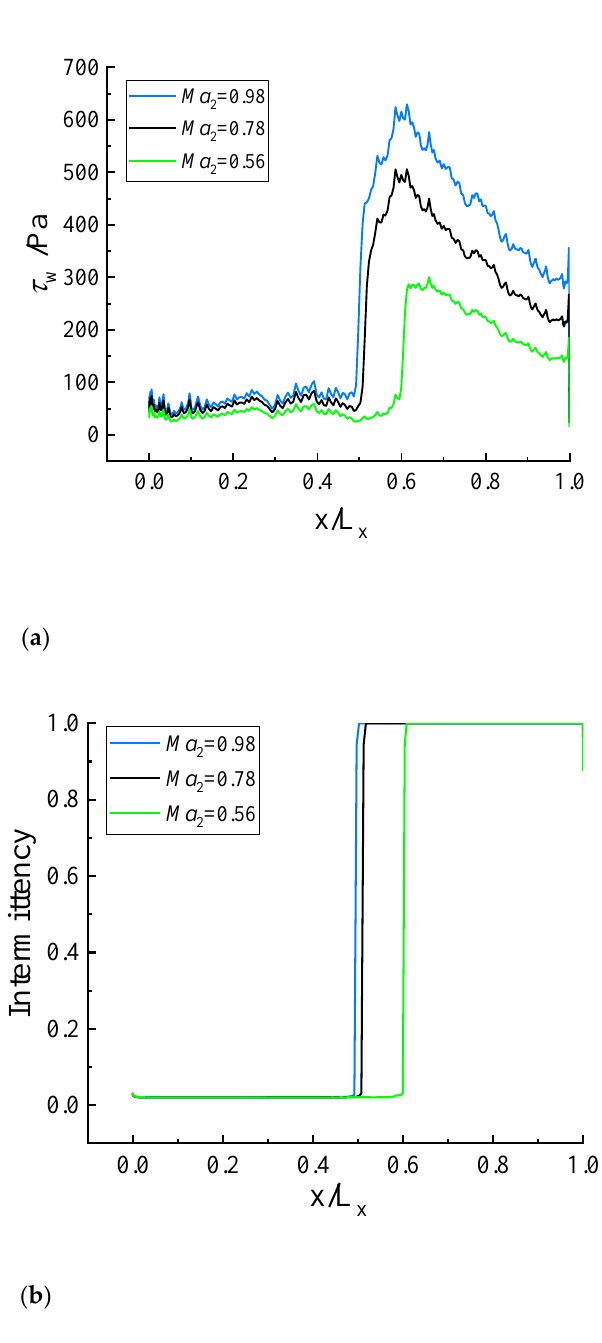
Figure 10. Intermittency and wall shear distribution of blade suction surface ( Ma < 1). ( a ) Wall shear; ( b ) intermittency.